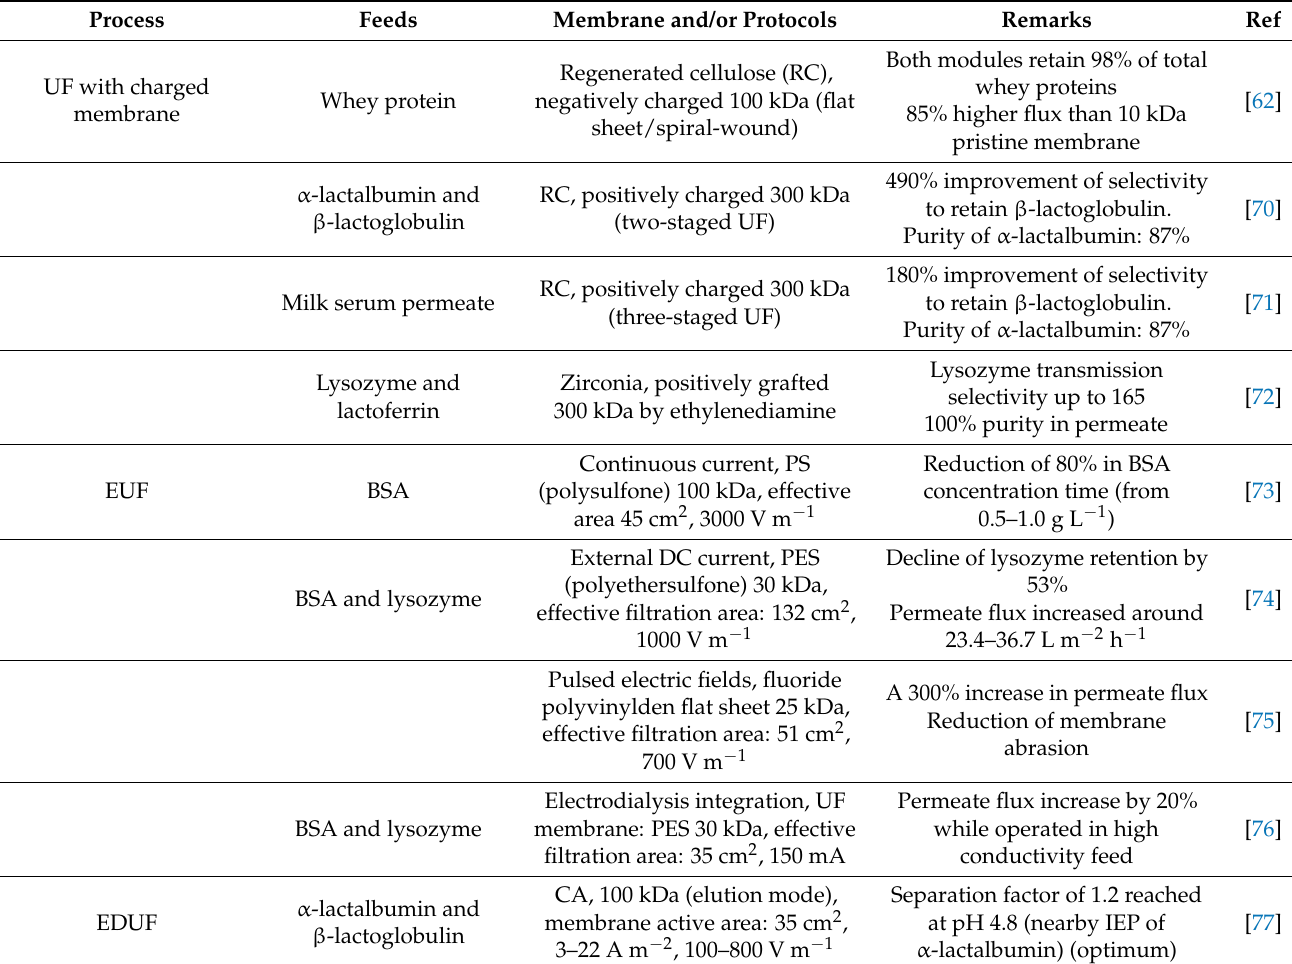
Table 4. Representative works of protein ultrafiltration